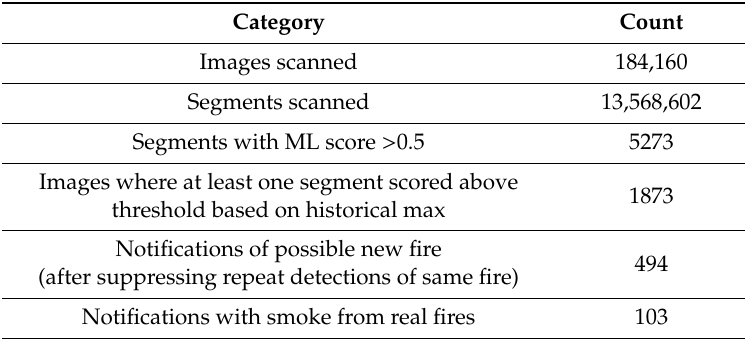
Table 3. Statistics from live detection system checking HPWREN